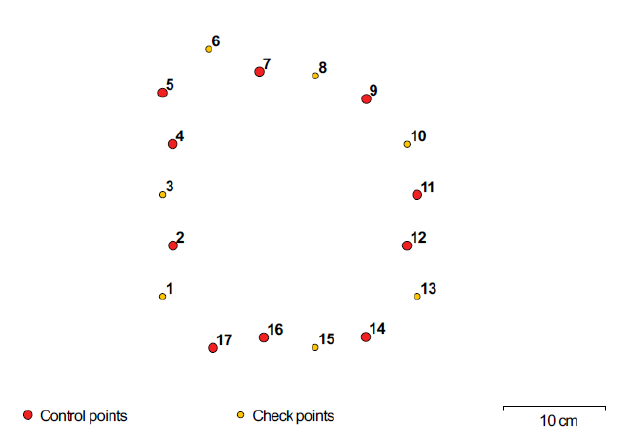
Figure 5. The distribution of control and check